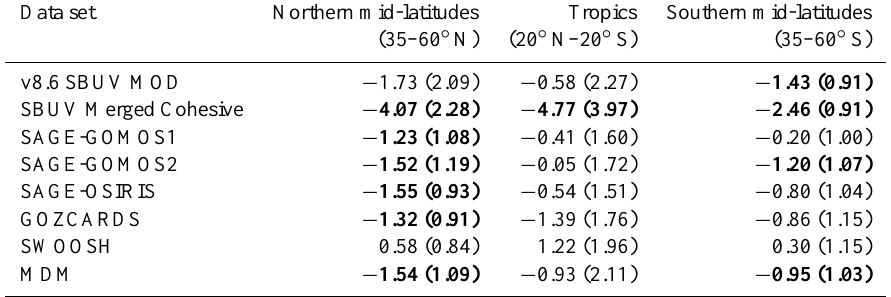
Table 9. As for Table 8 but for